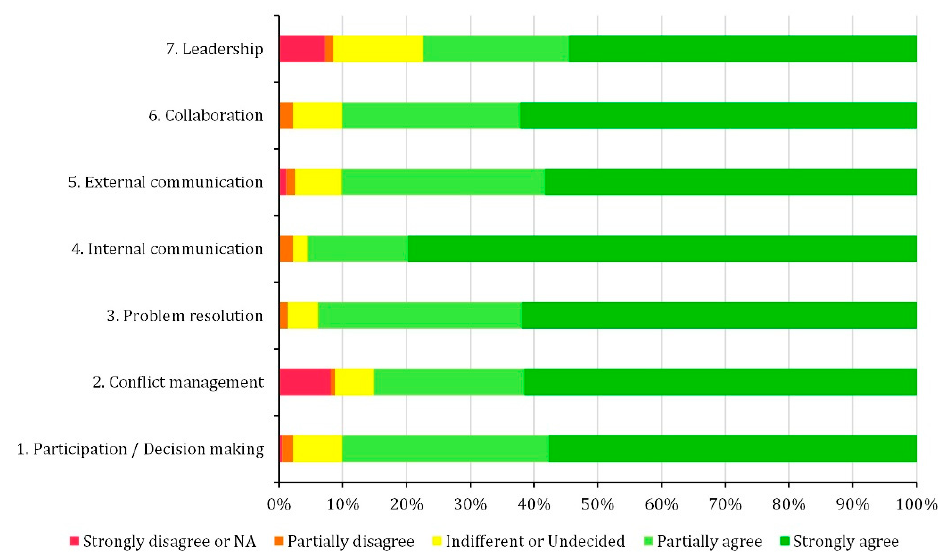
Figure 8. General scores of the working groups expressed in percentages.